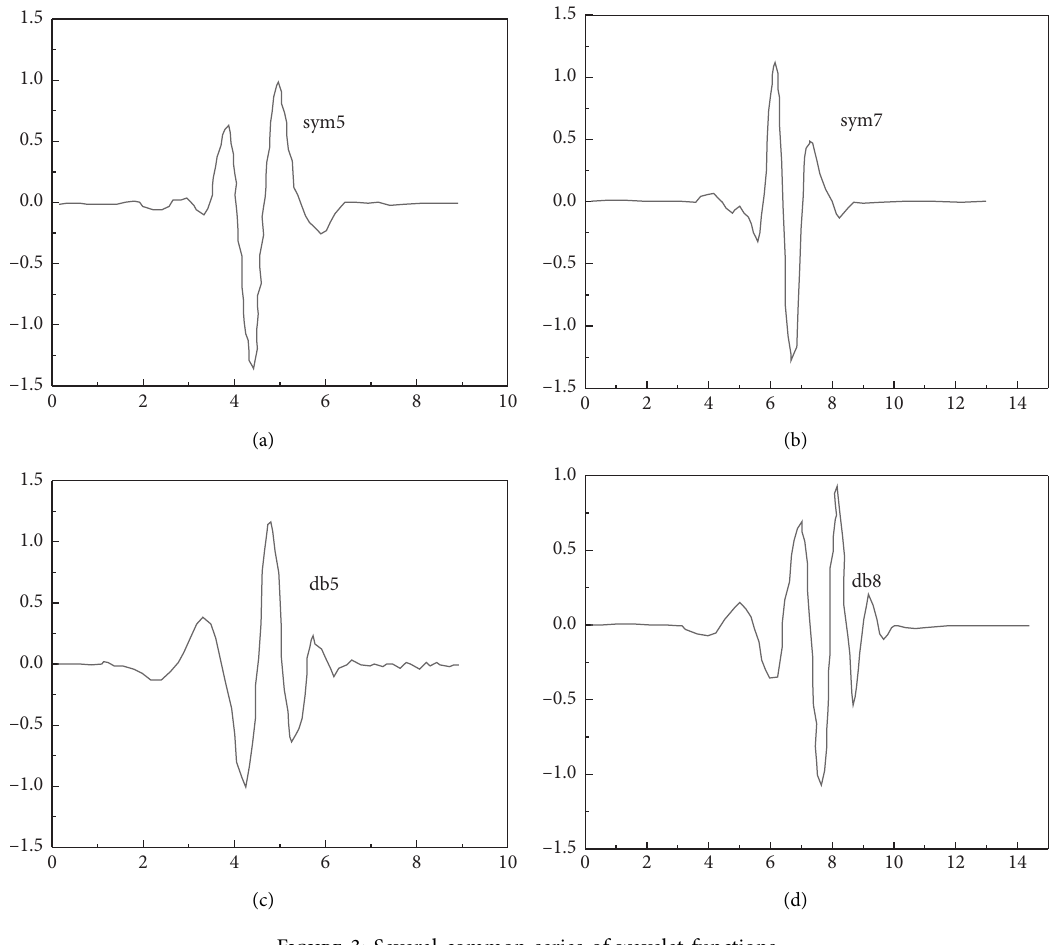
Figure 3: Several common series of wavelet functions.